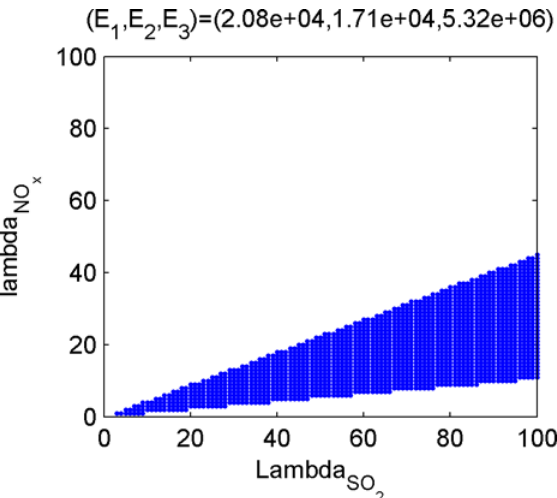
Fig 6. The dominant set relevant for (E 1 ,E 2 ,E 3 ) =